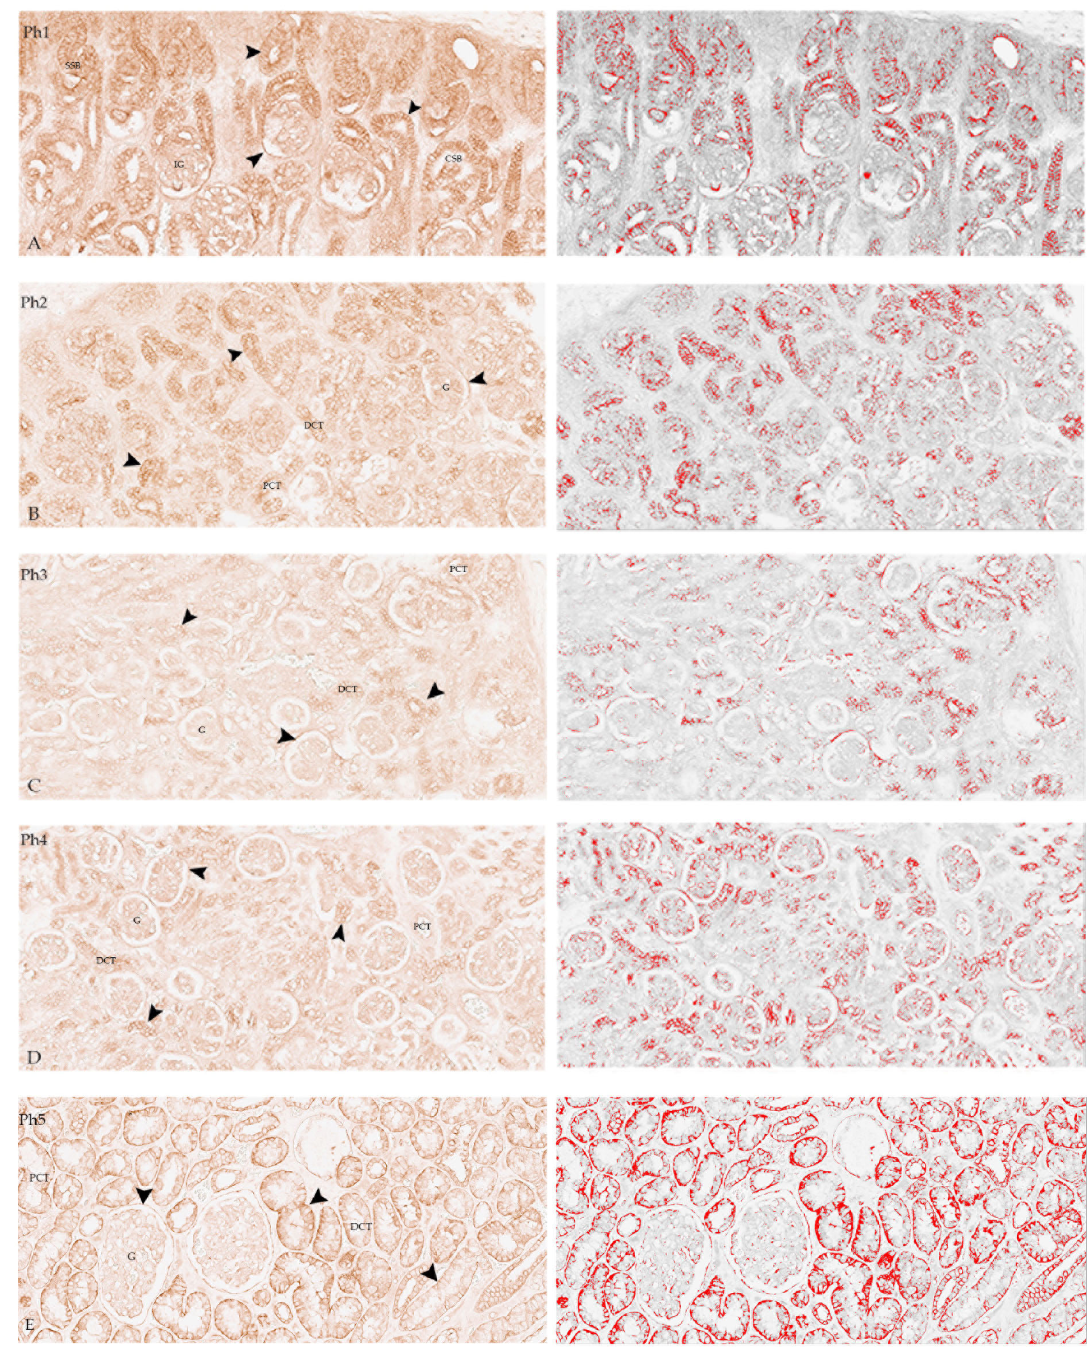
Figure 1. Fetal and postnatal kidneys stained with DLG1 (left), images highlighting the positive signal (red) that were used for the analysis of the area percentage of positive signal, obtained by subtraction of the median filter and thresholding (right). DLG1 (arrows) is expressed in glomeruli (G), proximal convoluted tubules (PCT), distal convoluted tubules (DCT), immature glomeruli (IG), and S-shaped bodies (SSB) in phase one (Ph1), phase two (Ph2), phase three (Ph3), phase four (Ph4), and phase five (Ph5). Ph2 to Ph4 correspond in intensity and localization of DLG1. Scale bar is 40 µ m. ( A , B ) Individual cells in developmental structures are strongly positive; ( C ) Moderate positivity in Ph3; ( D ) Intense positive expression in G and Bowman’s capsule; ( E ) diffuse positive expression in PCTs, DCTs, and Bowman’s capsule, but weak in G (left DAB/IHC without hematoxylin counterstain, all images 20×). For negative control, see Supplementary Figure S1.